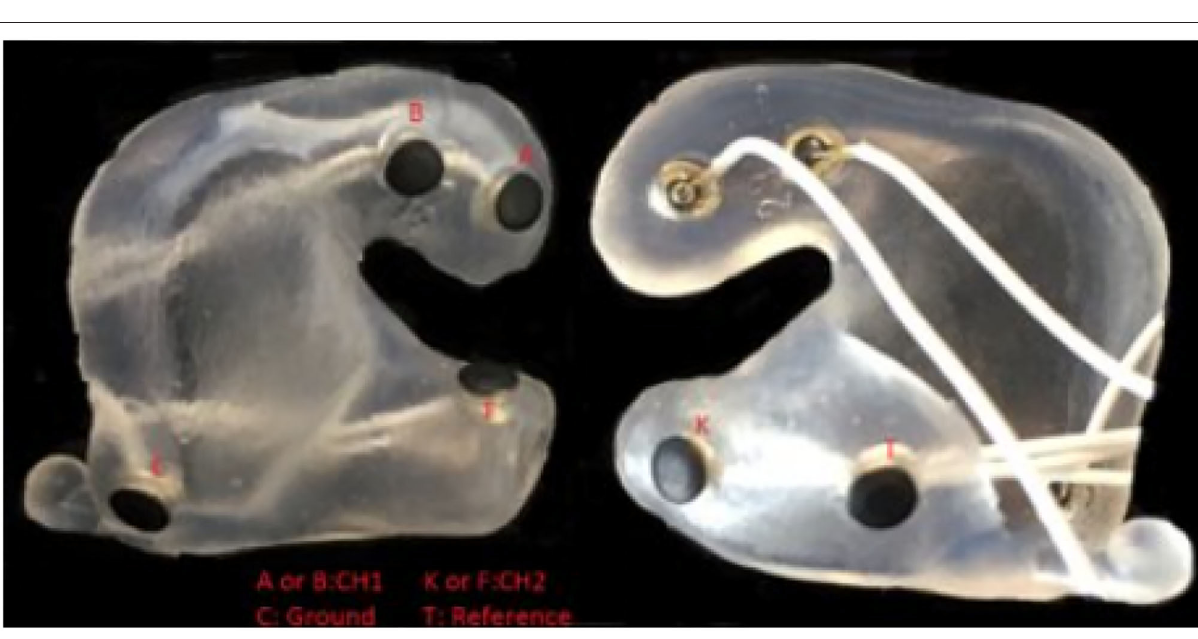
FIGURE 2 | Example of a soft silicone mold equipped with EOG